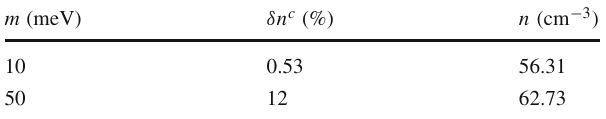
Table 3 The current number densities of neutrinos and the deviation of those from the instantaneous decoupling limit with a mass m including clustering effect by our Galaxy and not including neutrinos’ spectral distortions